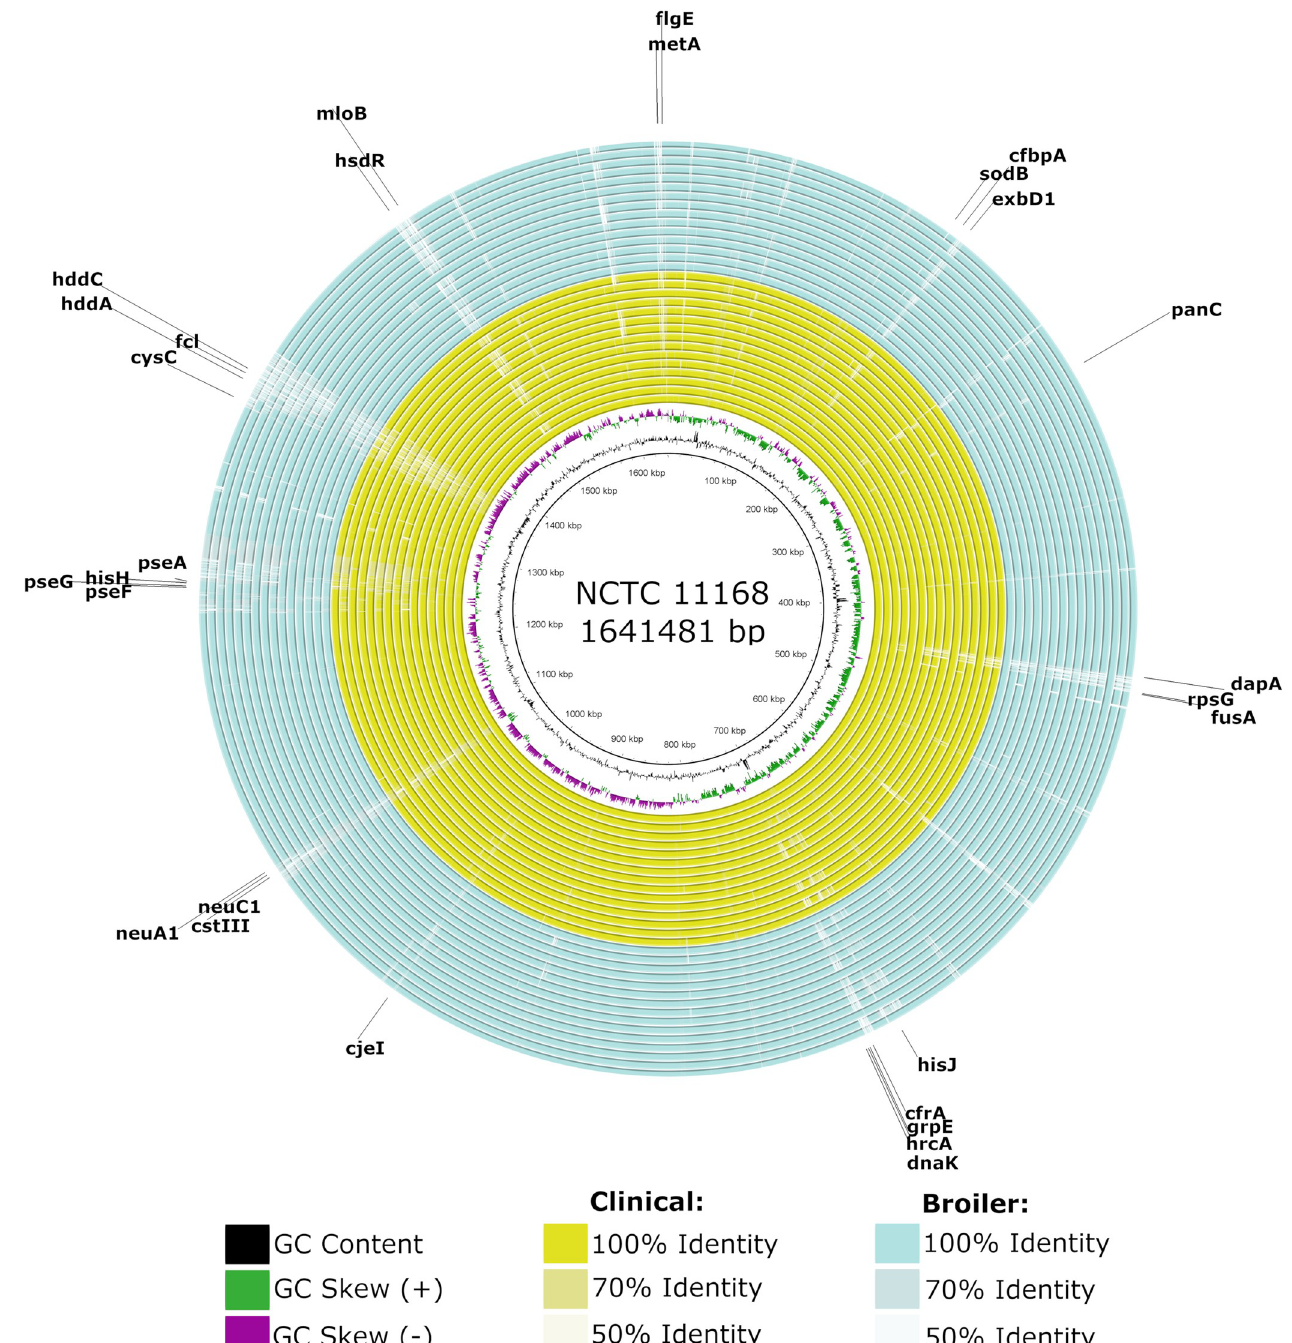
Fig 3. Multiple sequence alignment of human clinical and broiler C . jejuni isolates to NCTC 11168. White areas correspond to sequences with similarity values below the minimum threshold. Genomes are presented as CJC01 to CJC15 (from innermost to outermost yellow ring) and CJB16 to CJB30 (from innermost to outermost blue ring). Genes that overlap or neighbour gaps of low identity are indicated with